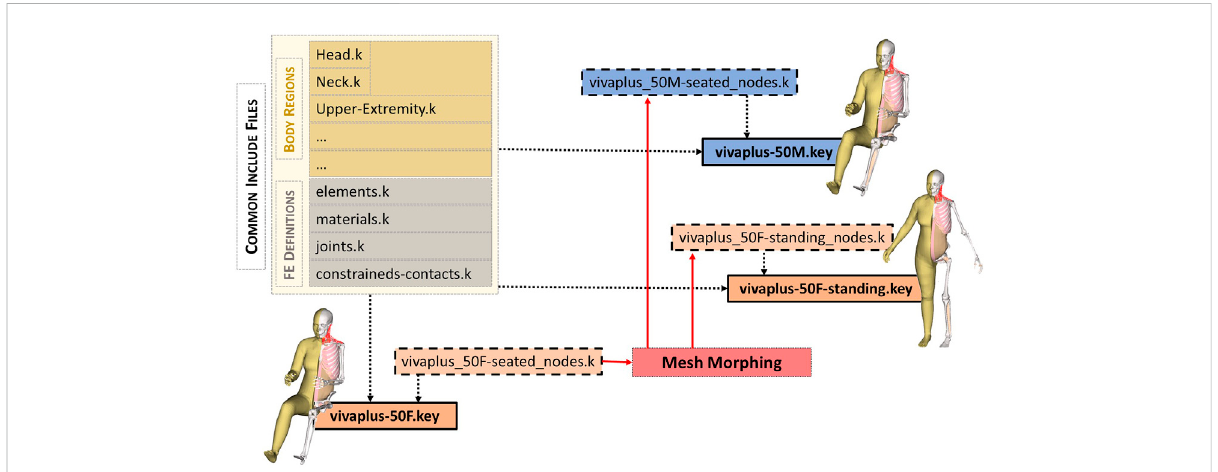
FIGURE 5 Include structure (LS-DYNA equivalent to functions in programming) of VIVA + models. The model de fi nitions are organized in a modular approach. The main “ key ” fi le (shown in boxes with solid borders) refers to the include fi les. The primary difference between the models is the ‘ nodes.k ’ include (shown in dashed boxes). The node de fi nitions of derivative models are generated through morphing (standing female and seated male shown for illustration).All theother model de fi nitions – part de fi nitions in thebody regions and other fi niteelementde fi nitions – are shared by all the